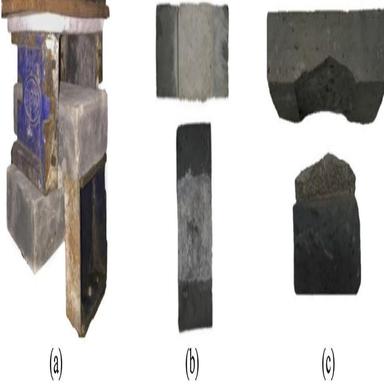
Characterization of tensile bond strength of masonry: (a) crossed brick sample, (b) cohesive failure (separation), (c) damage failure.